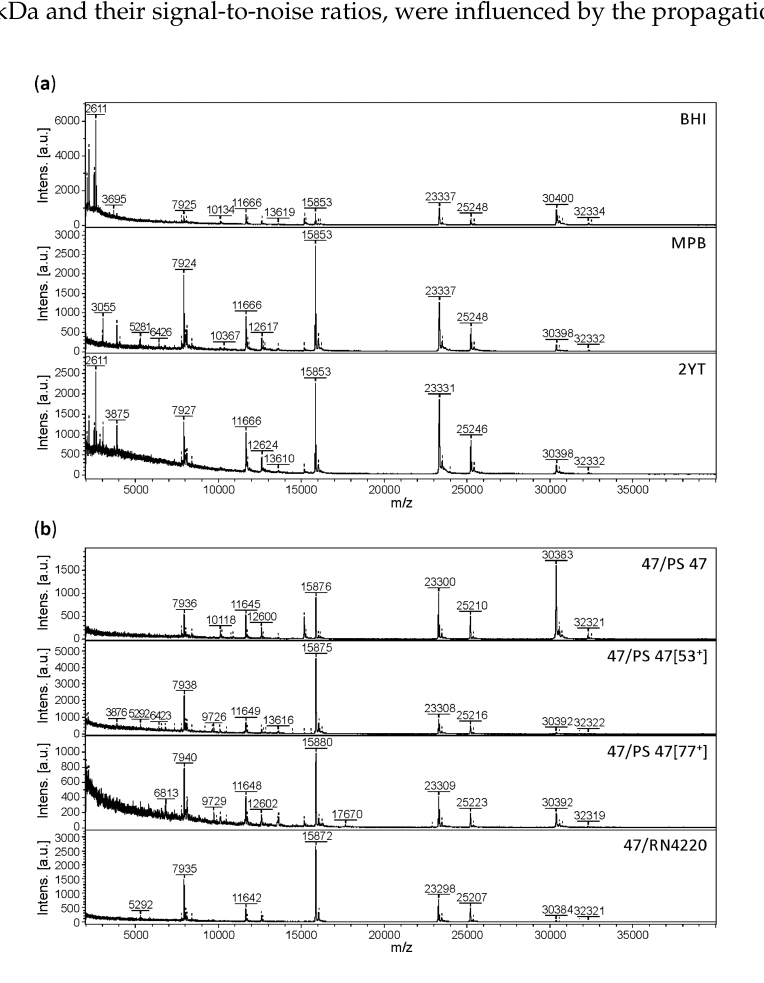
Figure 3. Comparison of the mass spectra of phage 3A using three different cultivation media ( a ) and phage 47 grown on four different propagation strains ( b